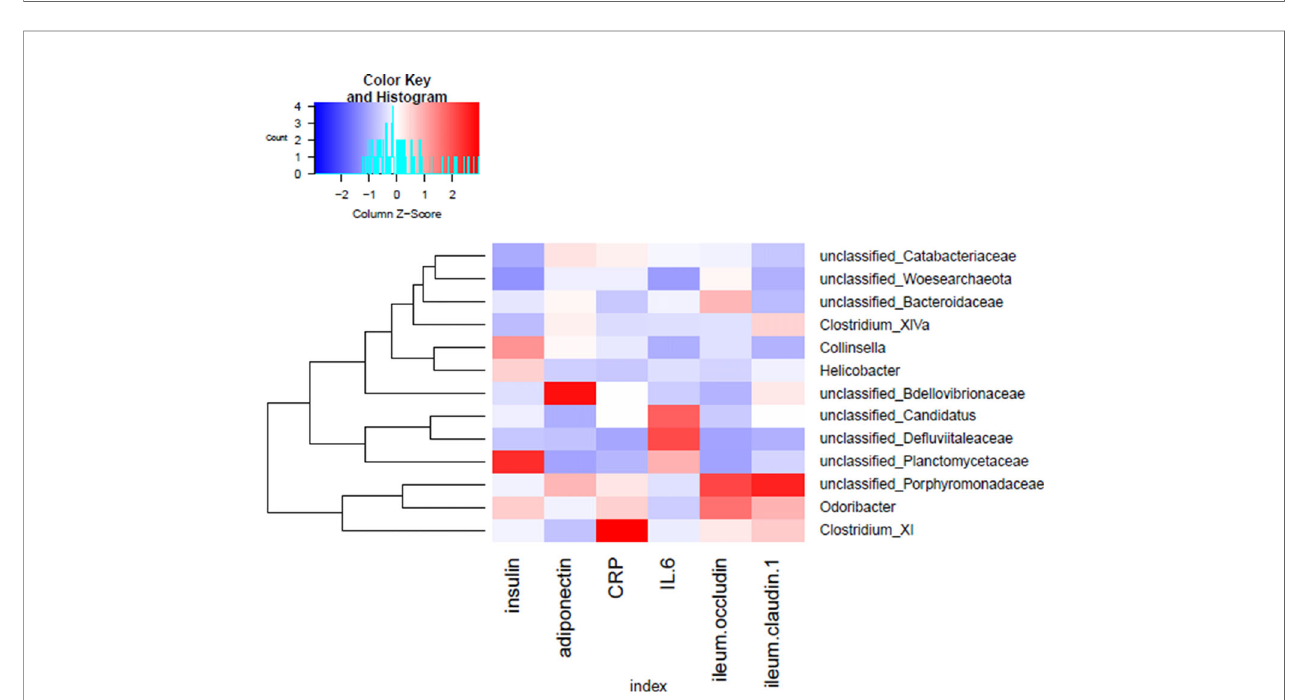
FIGURE 6 | Correlation analysis between the gut microbiota and T2DM-related phenotype in rats. Heatmap of correlation between the alterations in the gut microbial population and changes in host parameters related to insulin, in fl ammatory factors, and intestinal barrier function. Pearson correlation values were used for generation of the matrix.